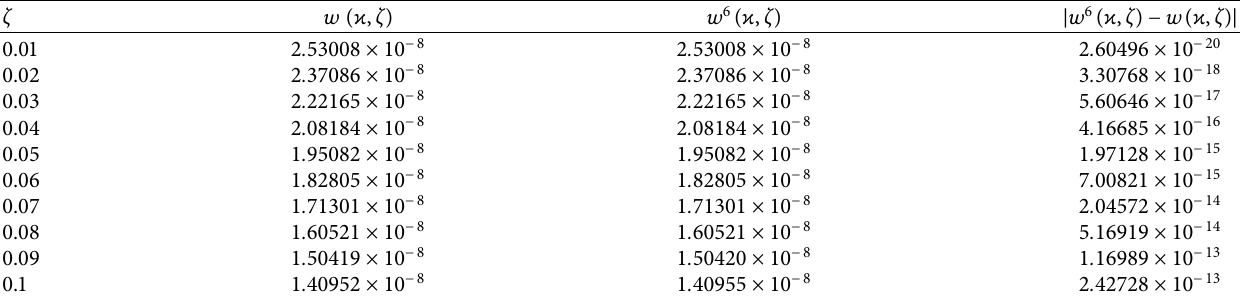
Table 7: | w ( ϰ , ζ ) − w 6 ( ϰ , ζ )| of Problem 1 at ϰ � 0 . 003 when ϖ � 1 . 0 determined by LRPSM at plausible locations in the range ζ ∈ [ 0 , 0 . 1 ] .